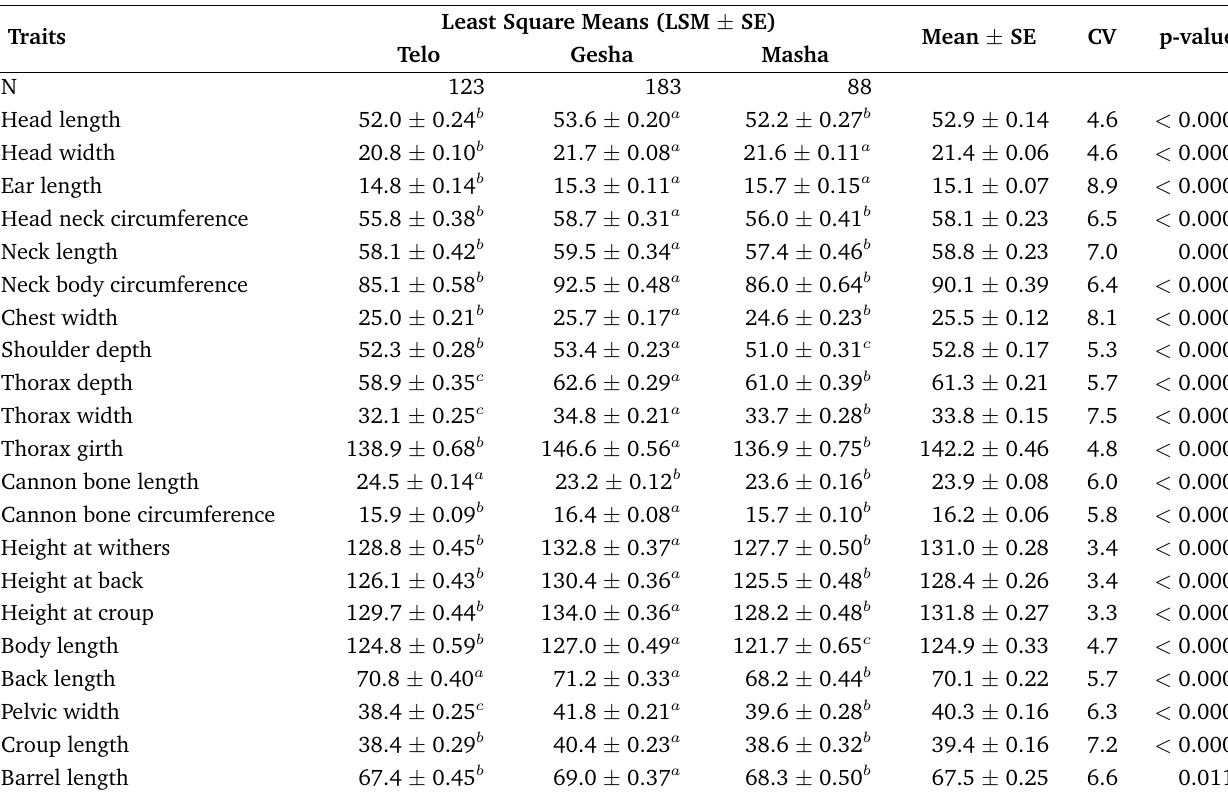
Table 6. Means and pairwise comparisons of morphometric measurements of the horses (both sexes) from different locations. Means within a row bearing different superscripts are significantly different; a indicates the largest